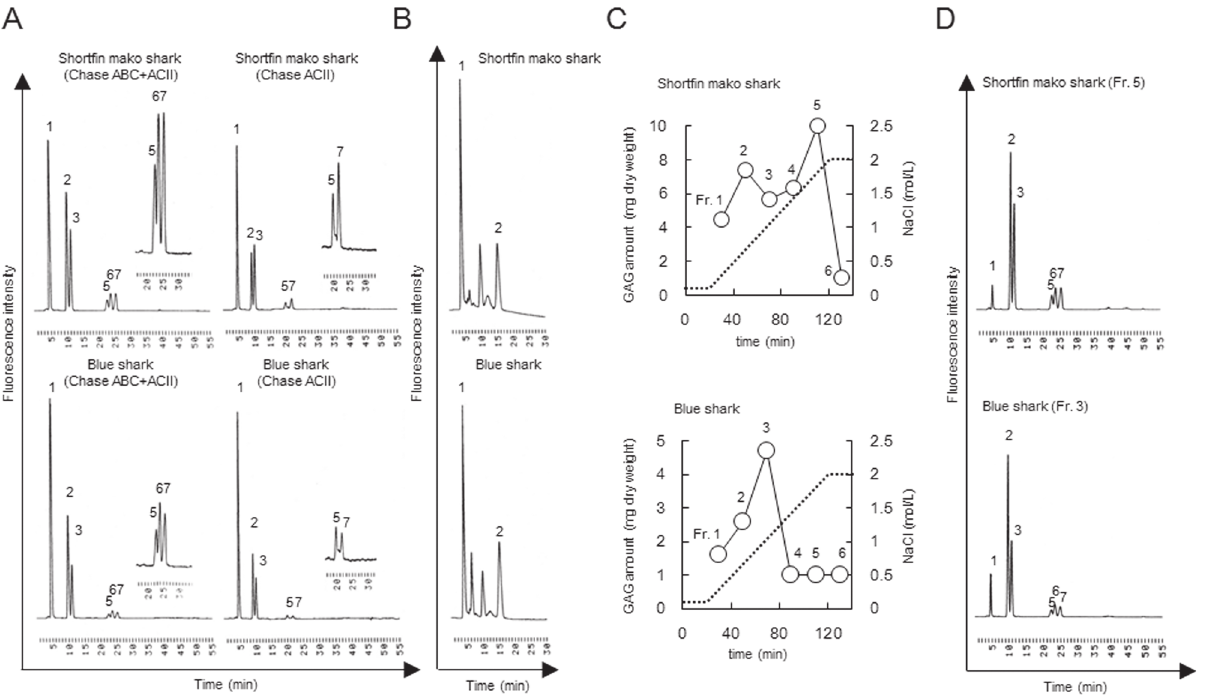
Fig 2. Purification of CS/DS from shortfin mako shark and blue shark fin without skin and cartilage. (A) Determination of CS/DS in shark fins. Briefly, 5 μ g of crude GAGs derived from samples were digested by 50 mU of ChaseACII and 50 mU of ChaseABC, and then resulting unsaturated disaccharides were subjected to reversed-phase ion-pair chromatography with sensitive and specific post-column detection. Peaks: 1, Δ Di-0S; 2, Δ Di-4S; 3, Δ Di-6S; 4, Δ Di-diS Δ Di-diS Δ DiUA-2S; 5, Δ Di-diS E ; 6, B ; 7, D . (B) Determination hyaluronic acid contents in crude GAGs. Unsaturated disaccharides obtained by digestion with ChaseABC and ChaseACII were analyzed by a graphitized carbon column and post column fluorometric detection. Peaks: 1, Δ Di-0S; 2, Δ Di- HA. (C) Purification of CS/DS from crude GAGs. The crude GAGs (10 * 20 mg of dry powder) were purified on DEAE-cellulose column as described under “ Materials and Methods ” . The dried powders obtained, after desalting and lyophilizing the 6 fraction samples, were weighed. (D) Chromatograms of unsaturated disaccharides of CS/DS derived from shortfin mako shark (Fr. 5) and blue shark (Fr. 3). Peaks: 1, Δ Di-0S; 2, Δ Di-4S; 3, Δ Di-6S; 4, Δ DiUA-2S; 5, Δ Di-diS Δ Di-diS Δ Di-diS E ; 6, B ; 7, D . Experiments were repeated twice with reproducible results.